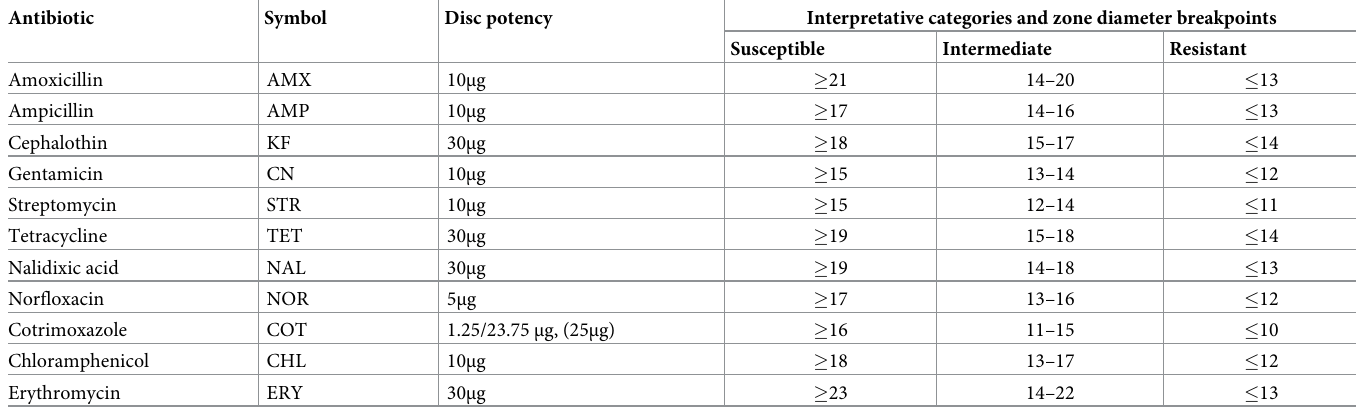
Table 1. Antibiotic susceptibility test interpretative criteria and cut-off values for coliforms [31]. Antibiotic Symbol Disc potency Interpretative categories and zone diameter